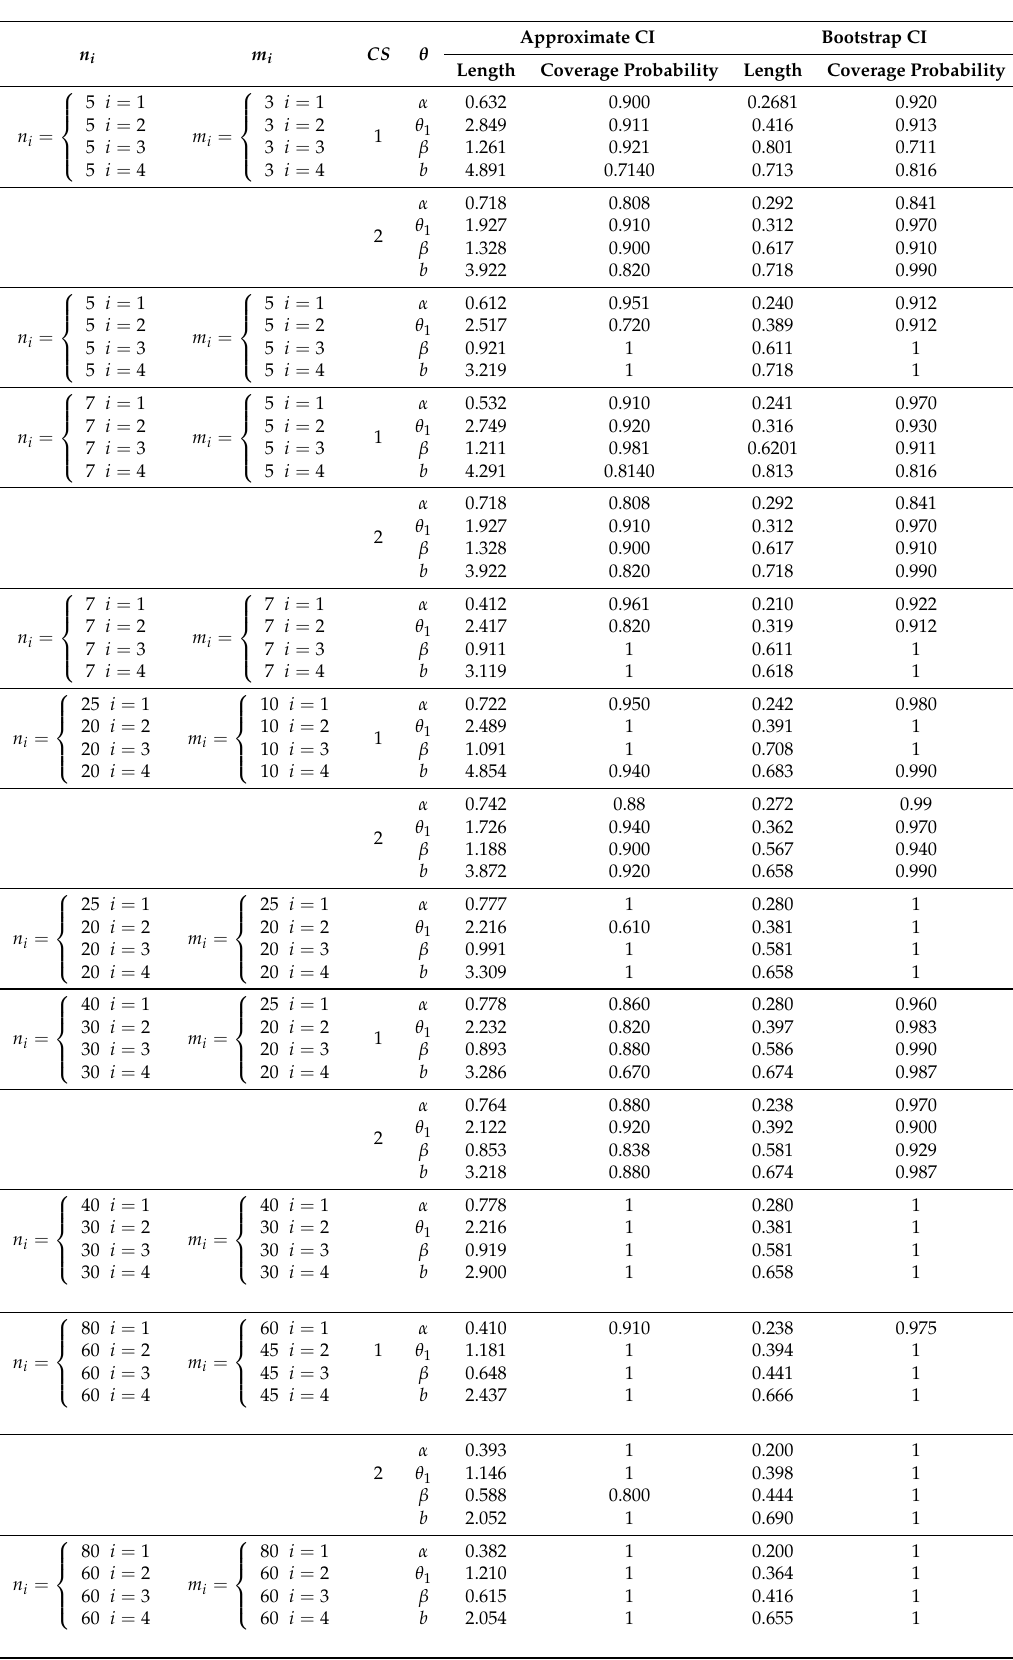
Table 7. Lengths and coverage probabilities of 95% approximate and bootstrap CIs of α , θ 1 , γ and b with true values ( γ = 1.4, α = 0.5, θ 1 = 0.7 and b = 1.2), k = 4, ν 1 = 10, ν 2 = 16, ν 3 = 20 and ν 4 = 25. Approximate CI Bootstrap CI n i m i CS θ Length Coverage Probability Length Coverage